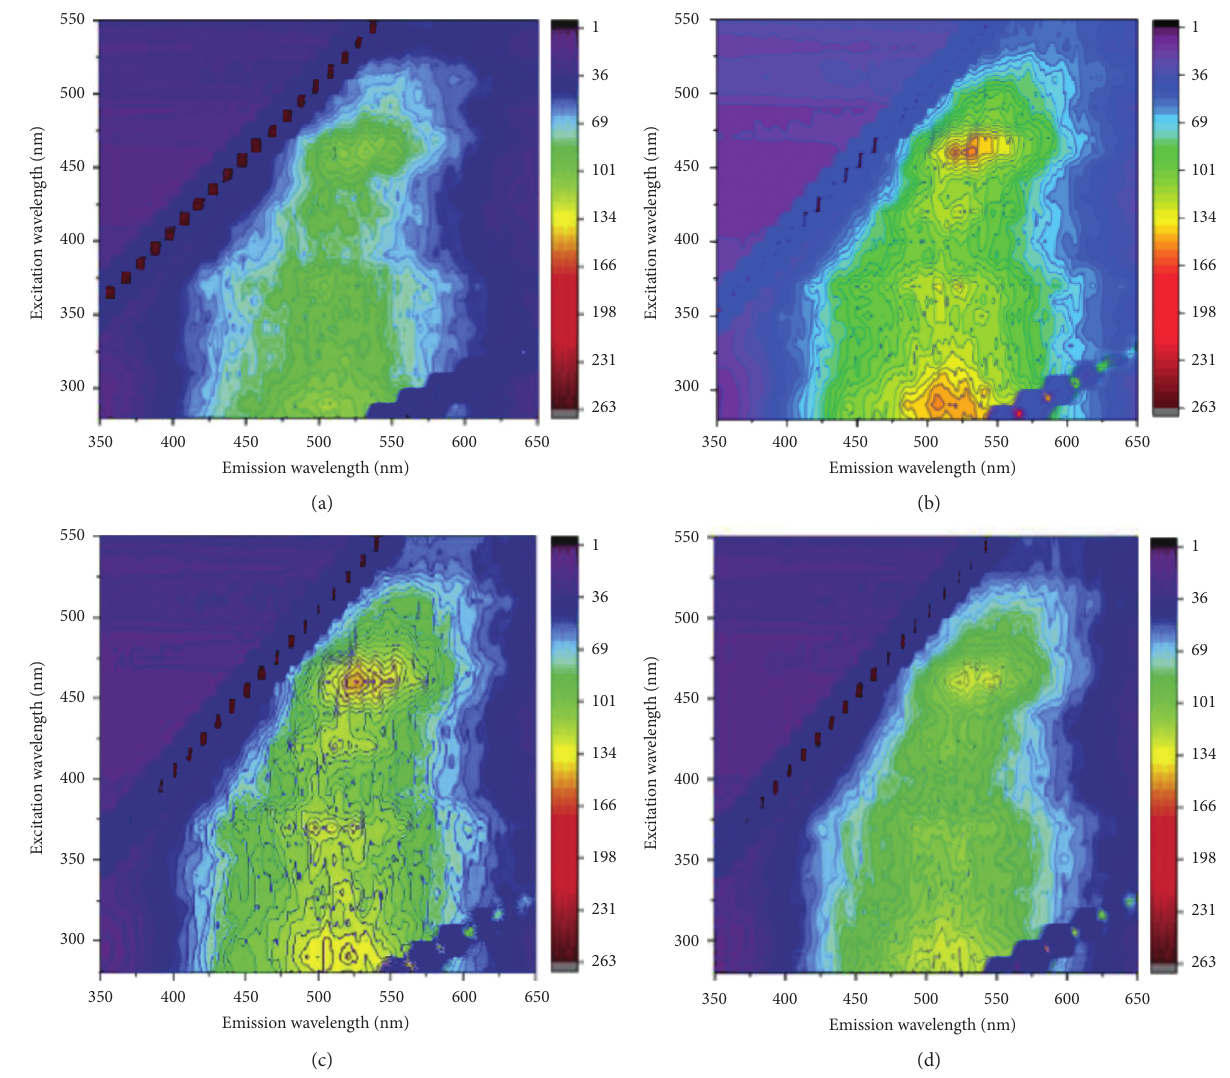
Figure 2: Fluorescence spectra of HA in different maize returning methods on topsoil. Note. CK: no straw application; SCR: straw mulching; MBR: straw deep ploughing; SEDI: straw enrichment and deep incorporation. (a) Topsoil: CK. (b) Topsoil: SCR. (c) Topsoil: MBR. (d) Topsoil: